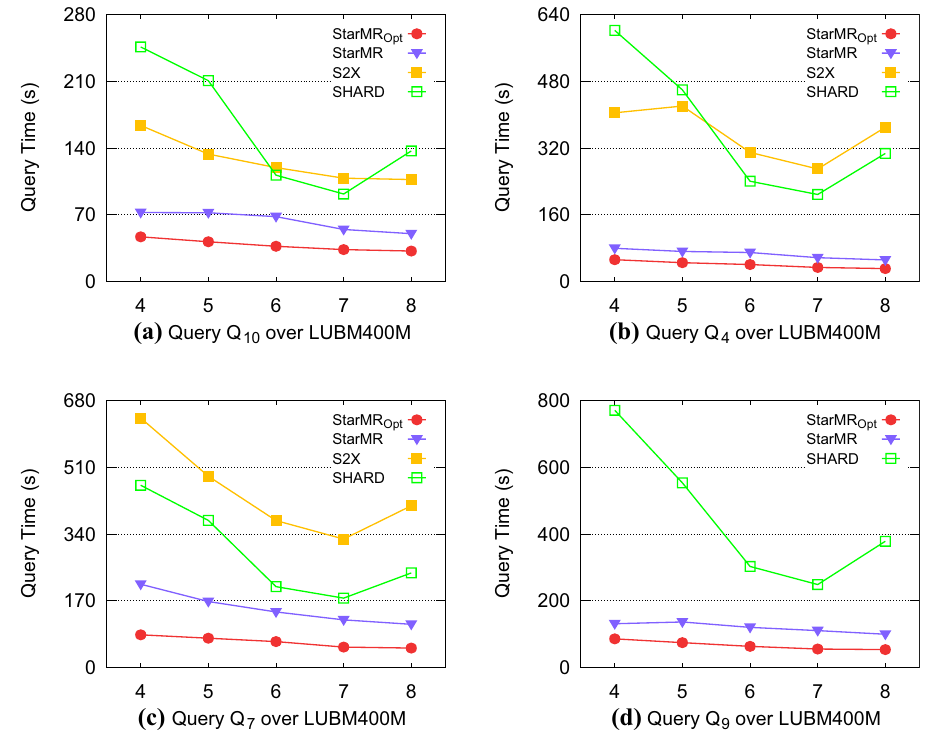
Fig. 10 Scalability on cluster